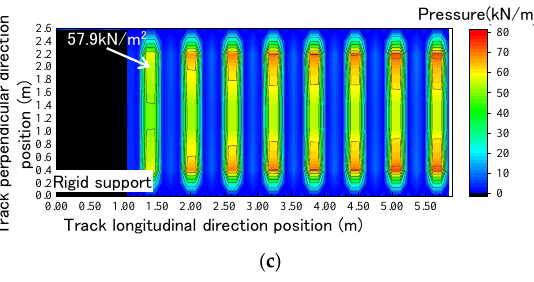
Figure 19. Distribution of the pressure on the sleeper bottom plane with “step-down” running (CASE4): ( a ) ladder track (Support A); ( b ) ladder track (Support B); ( c ) PC sleeper track.